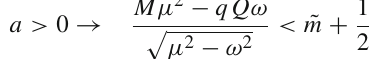
Fig. 10 (Left) confluent hypergeometric function U [− 0 . 8 , 27 . 8 ; 2 . 17 r ] for quasibound state is an increasing function of r . (Right) confluent hypergeometric function U [ 3 . 97 , 7 . 99 ; 0 . 09 r ]